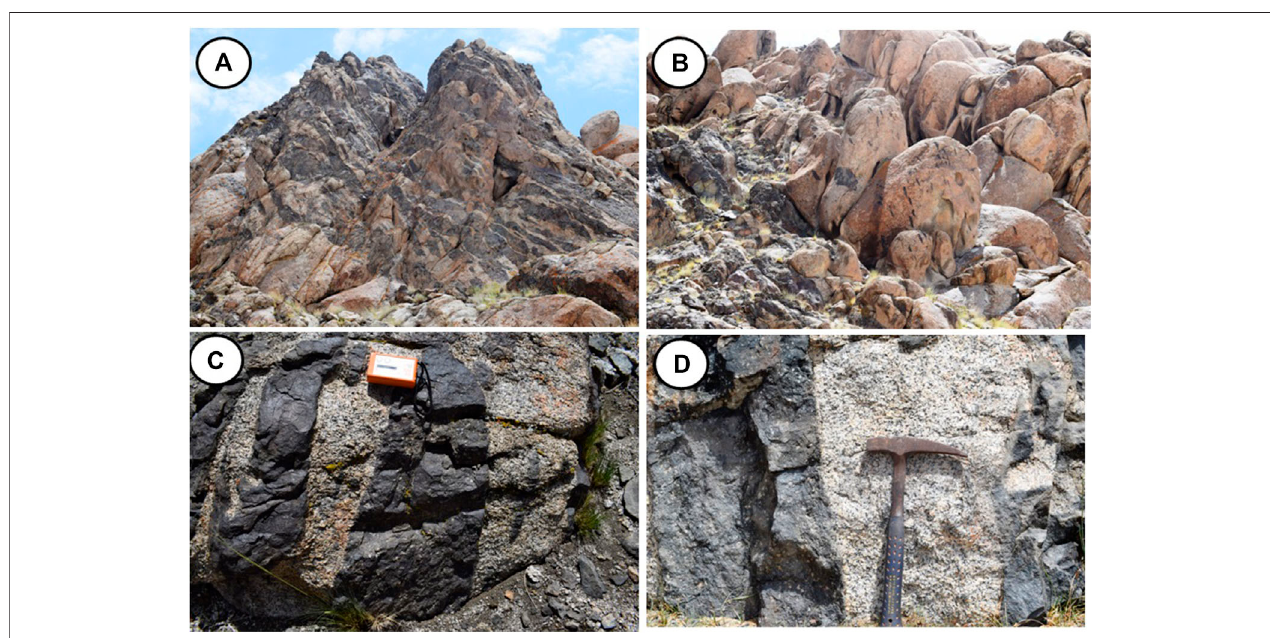
FIGURE 6 | (A) Hillock showing disrupted ma fi c to hybrid synplutonic dykes and sheets injected into most crystallized granite. Note that synplutonic dykes and sheets are discontinuous and have got disrupted appearing pillowed but they broadly follow the same strike direction (NE-SE). (B) There are numerous ma fi c to hybrid enclaveglobulesthatareoffsetfromdykesandsheets. (C) Closerviewofpartofma fi candhybridsynplutonicdykes. (D) Closerviewofpartsofhybridsynplutonicdykes. Note the sharp contact and straight contact outline of dyke with host granite, and felsic (quartz and K-feldspar) phenocrysts (xenocrysts) present in the hybrid synplutonic